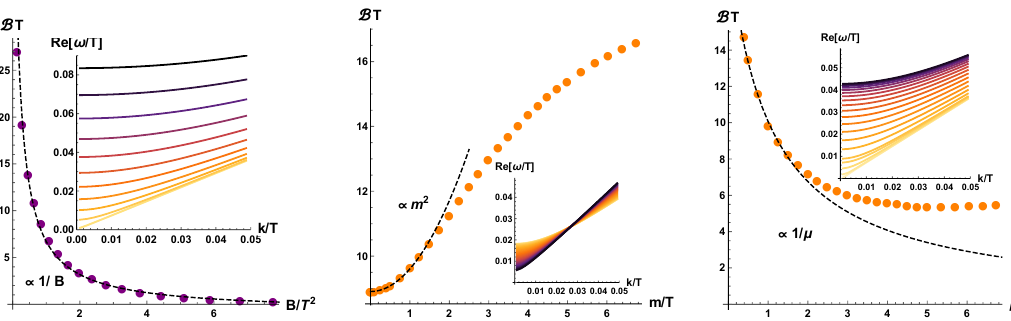
Figure 13 . The coe(cid:14)cient B extracted from the dispersion relation of the type-B magnetoplasmon Re [ ! ] (cid:24) C + B k 2 as a function of the parameters of the system. Left: As a function of the dimensionless magnetic (cid:12)eld B=T 2 (cid:12)xing m=T = (cid:22)=T = 1. The inset shows the dispersion relation of the magnetoplasmon increasing the magnetic (cid:12)eld (from orange to black). Center: As a function of the graviton mass (cid:12)xing (cid:22)=T = 1 and B=T 2 = 0 : 5. The inset shows the dispersion relation of the magnetoplasmon increasing m=T (from orange to black). The dashed line shows the low m quadratic scaling compatible with the hydrodynamic formula. Right: As a function of the dimensionless chemical potential (cid:22)=T (cid:12)xing m=T = 1 and B=T 2 = 0 : 5. The inset shows the dispersion relation of the magnetoplasmon increasing the chemical potential (from orange to black). The dashed line shows the (cid:24) 1 =(cid:22) scaling compatible with the hydrodynamic formula.